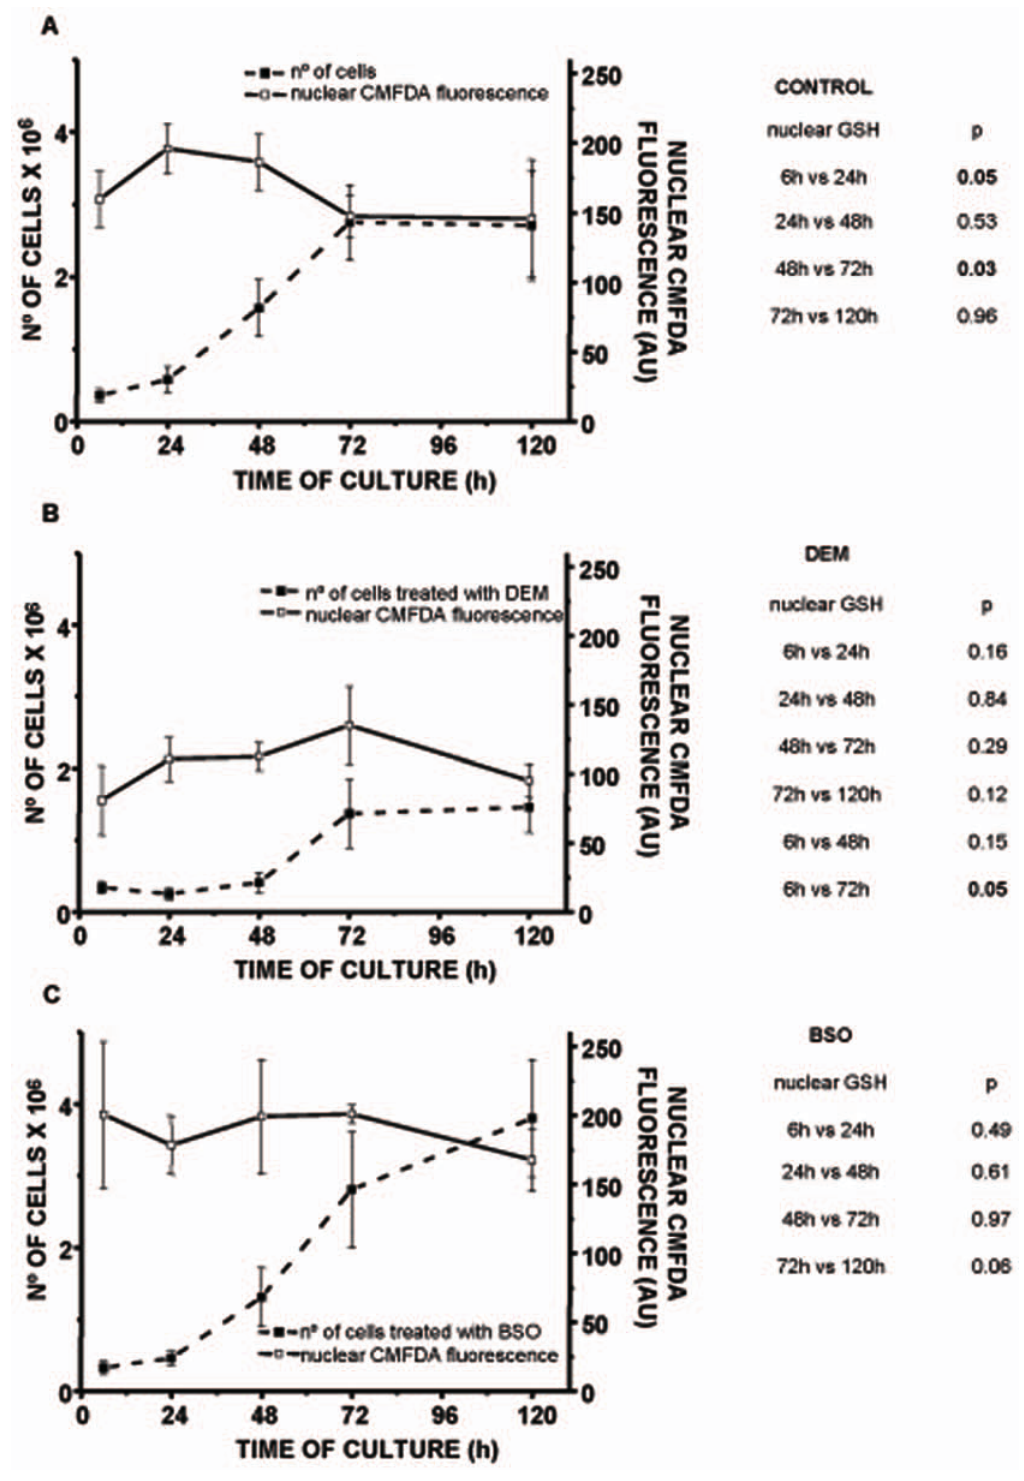
Figure 5. The relationship of the nuclear GSH level and the rhythm of cell growth. The consequences of the GSH depletion by DEM and BSO on the cell growth are shown on the panel B and C, respectively. Control cells are presented at the panel A. The mean CMFDA fluorescence in nuclear area (defined by Hoechst staining, see fig. 3) was obtained as described in materials and methods, and the profile of the cell growth was characterized by cell number. The results are presented as mean values of at least 4 experiments.